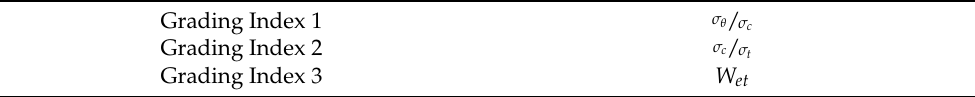
Table 4. The grading index corresponds to the symbol description.